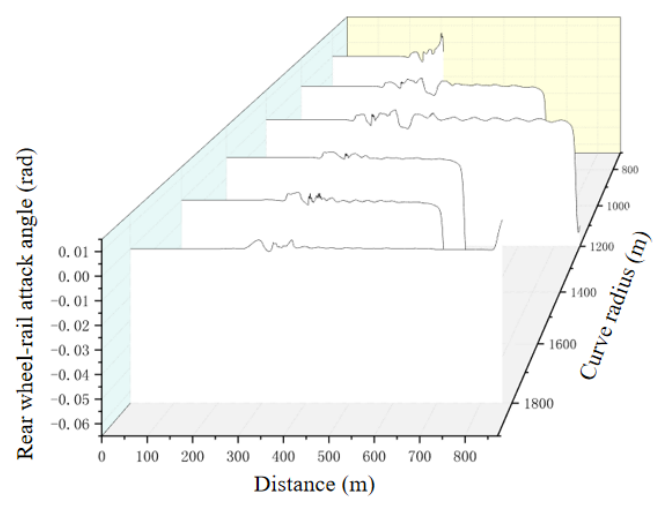
Figure 11. Changing curve of the rear wheel–rail attack angle. Before reaching the critical derailment speed, the train on group B line runs unstably with the process of speed increasing. In order to study whether the wheel–rail attack angle of the train changes abnormally or not, the train runs on the group B line at a nonlinear critical speed. The relationship of the attack angle between the front wheel and the track is obtained and is shown in Figure